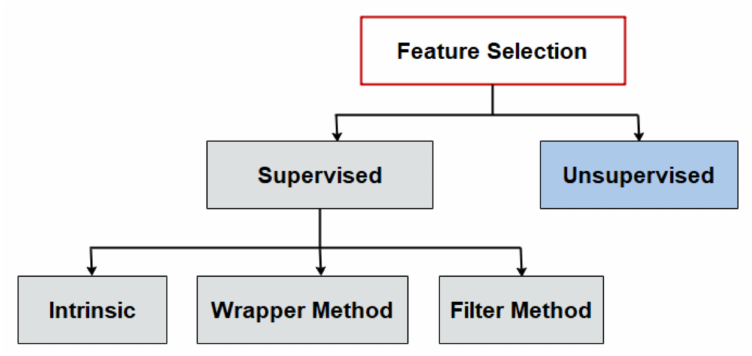
Figure 2. Feature selection